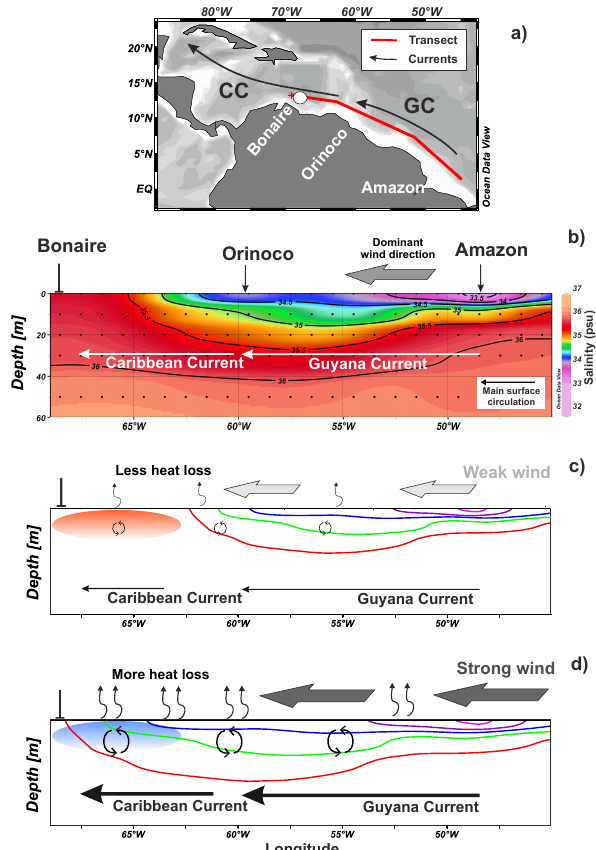
Fig. 13. (a) Map showing the transect of interest (red line) and the dominant surface currents (Guyana Current, GC; Caribbean Cur- rent, CC). (b) Observed sea surface salinity (SSS) in the upper 60m along a transect from the western tropical Atlantic to the south- eastern Caribbean Sea. Freshwater discharged by the Amazon and Orinoco rivers contribute to freshening of the western tropical At- lantic that extend northwestward due to transport by Guyana and Caribbean Currents. (c) and (d) Response of sea surface conditions under two different surface wind strength scenarios. (c) Weak wind scenario: reduced extent of fresh water (contour colour lines) trans- port northwestward due to reduced Guyana/Caribbean current sys- tem, and reduced heat loss and vertical mixing at sea surface that in turn contribute to warmer sea surface temperature (SST). (d) Strong wind scenario: intensification of surface water transport from the western tropical Atlantic to the Caribbean by surface current system and enhanced heat loss and vertical mixing at sea surface which in turn reduce SST, thus contributing to colder and less saline condi- tions around